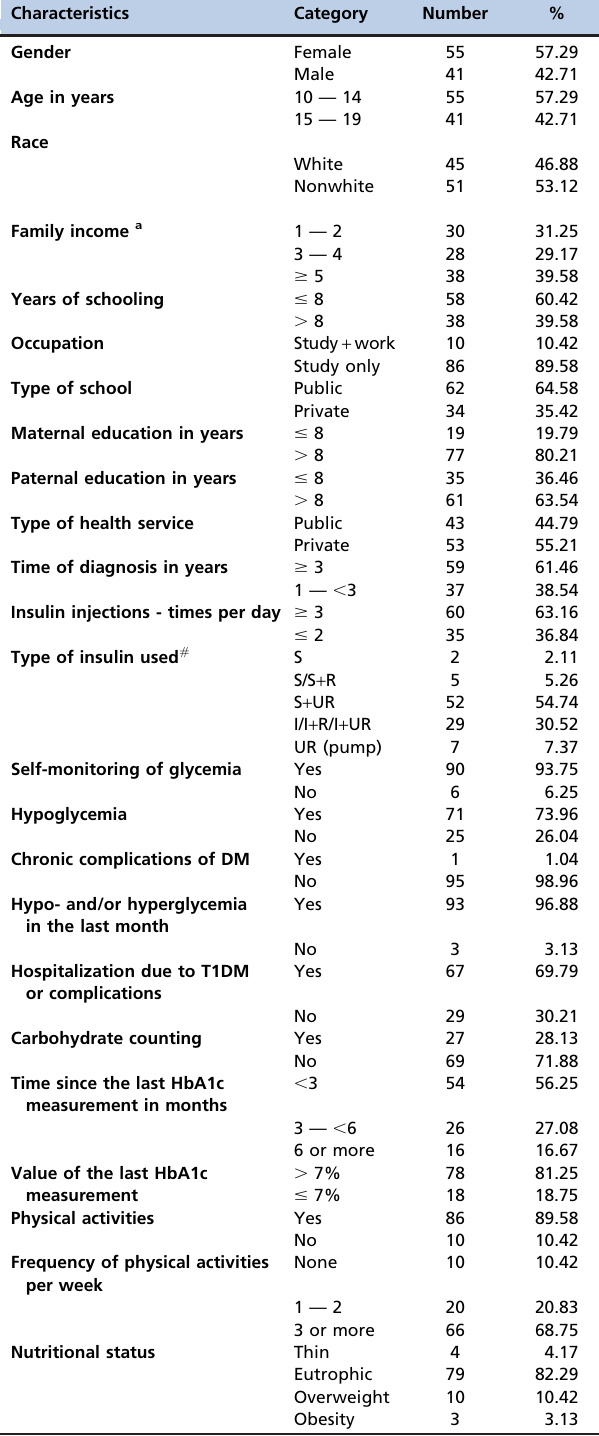
Table 1 - Sociodemographic, clinical and treatment characteristics of 96 adolescents with type 1